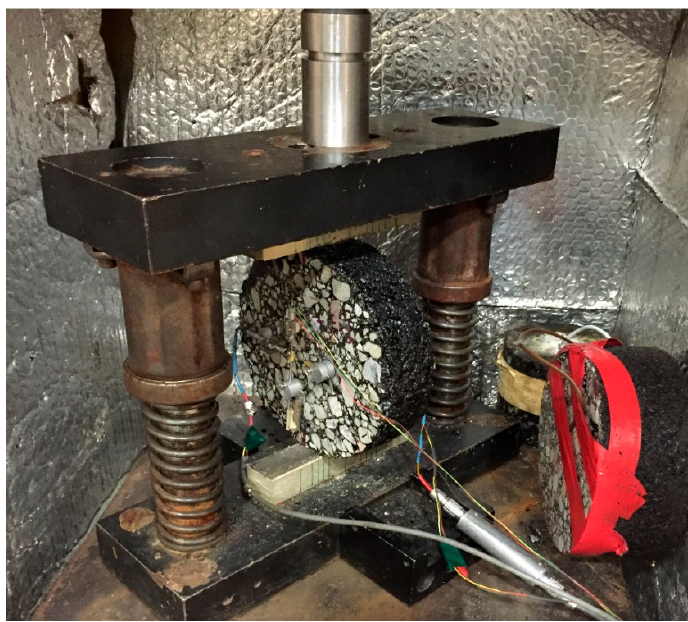
Figure 5. Instrumentation of the specimens for creep compliance testing.